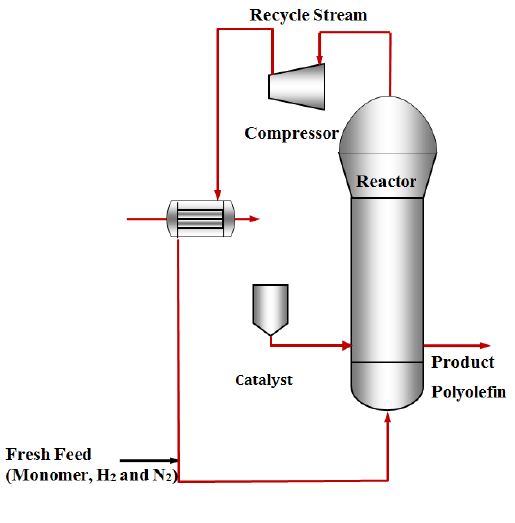
Figure 8. A process flow diagram representing the polymerization process of olefin in a gas-phase fluidized bed